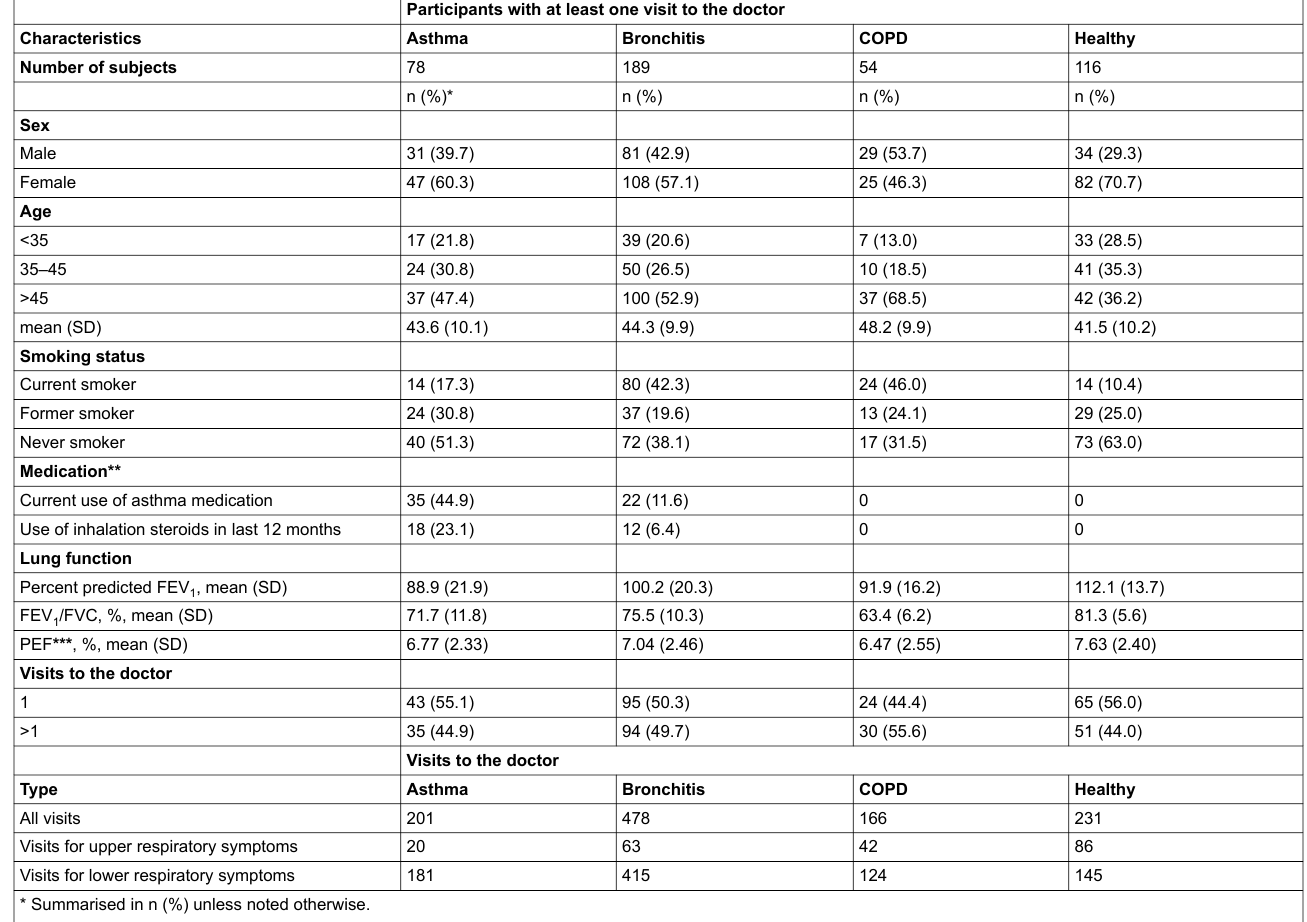
Table 1: Characteristics of participants who reported doctor visits for respiratory symptoms in the SAPALDIA diary study.